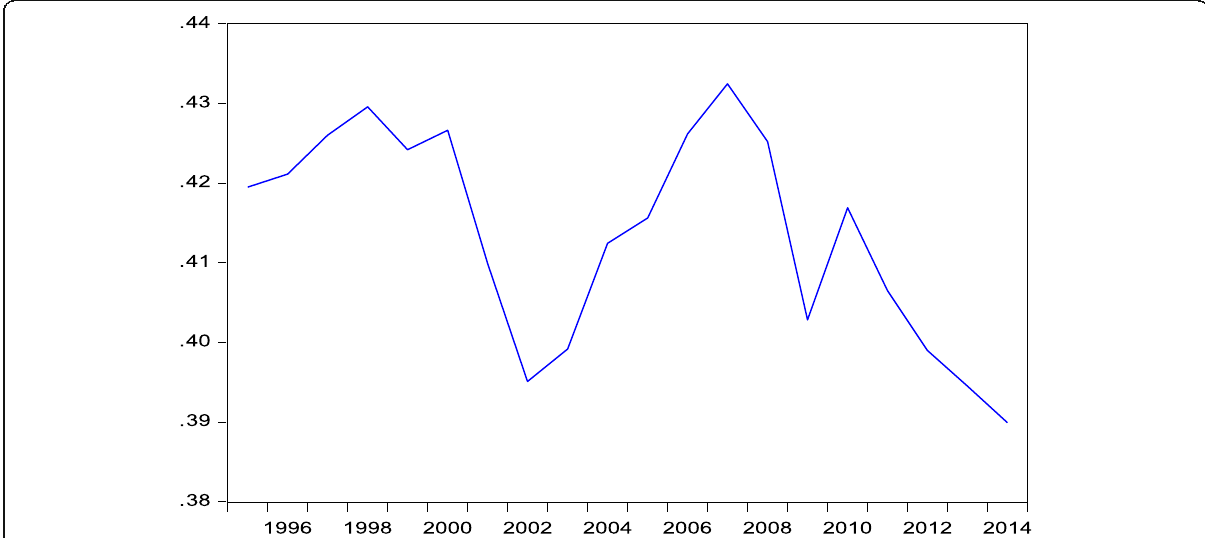
Fig. 5 Cost share of capital, Switzerland 1995-2014. Data source: Capital and Labour income, employment and hours worked, https://data.snb.ch/ de/topics/uvo#!/cu. Capital stock,